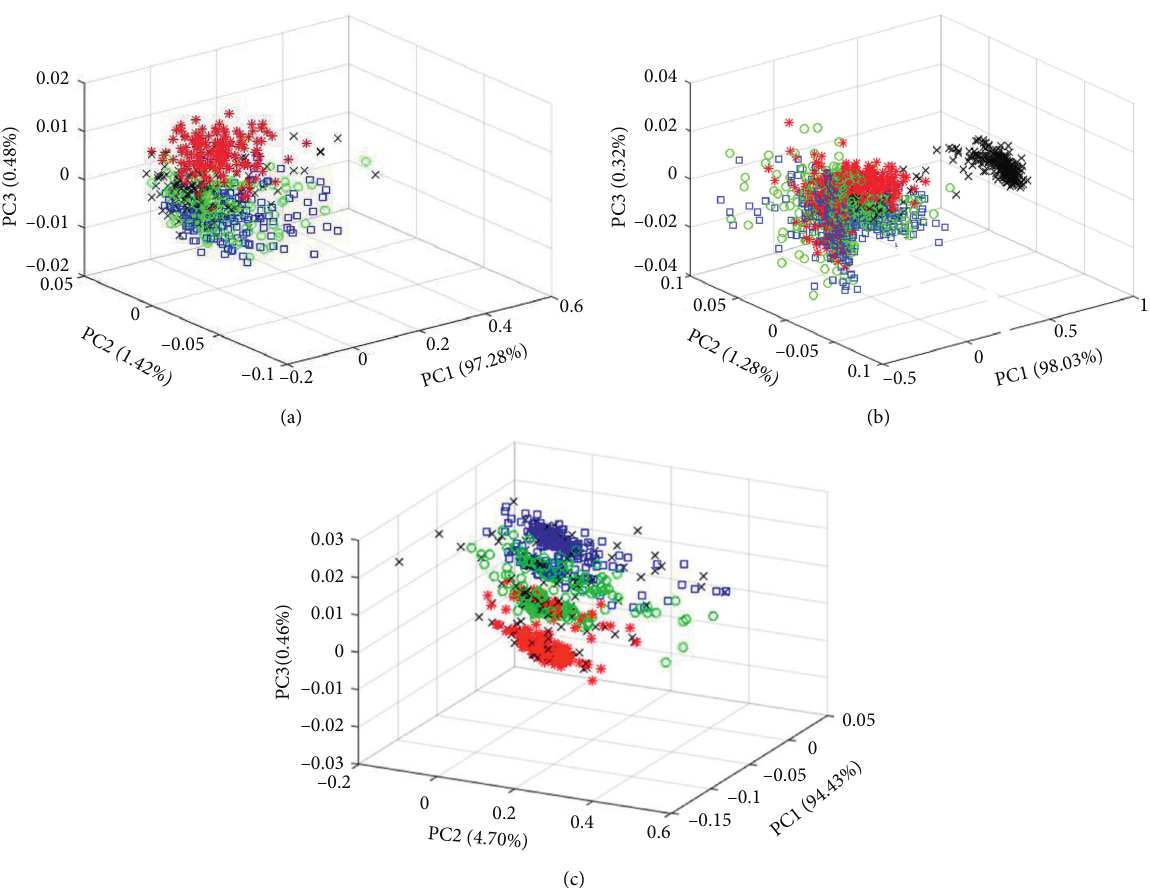
Figure 4: Three-dimensional score plots of the first three principal components derived from spectral features (a), morphological features (b), and combination of spectral and morphological features (c), respectively. The dots in plots represented Thai jasmine rice ( ∗ ), jasmine sticky rice (O), Simiao rice ( □ ), and Northeast Wuchang rice ( ×